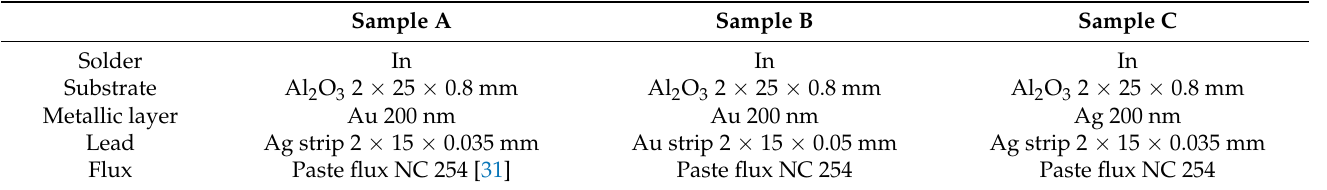
Table 1. Configuration and dimensions of samples A, B and